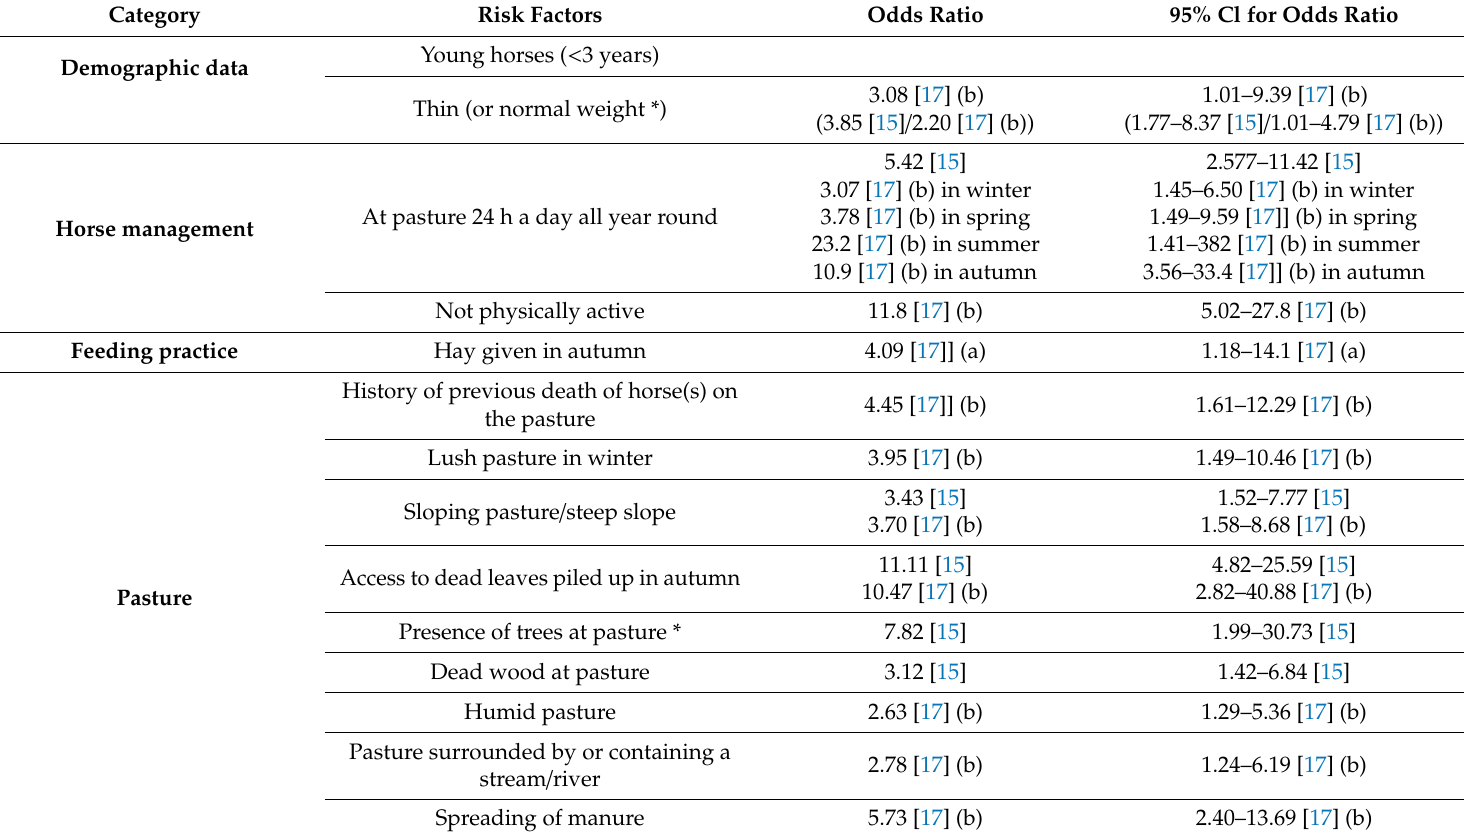
Table 2. Risk factors identified in from former epidemiological studies